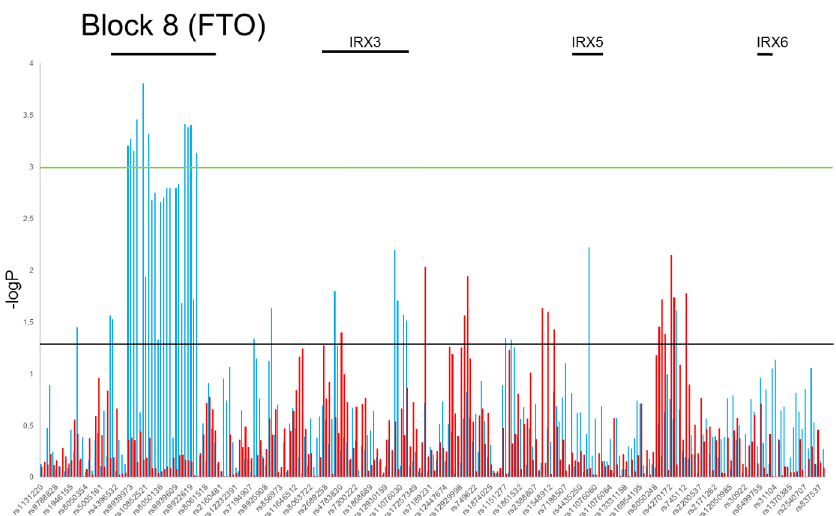
Fig 4. Distribution of estimated p values of the Chi square test in overweight phenotype stratified by age and sex. P values were calculatedin the test of independence betweenthe overweight phenotype and MAFs at tested SNPs (S5 Table). The y axis shows the − log 10 p values of 262 SNPs obtainedin overweight versus normalweight association analysis, and the x axis shows their rs numbers. Horizontalblack and green lines represent the thresholds of p = 0.05 for significancewithout multiplecorrection and p = 8.2E-04 for LD block significance, respectively. Red and blue columns representsfemales and males group, respectively.